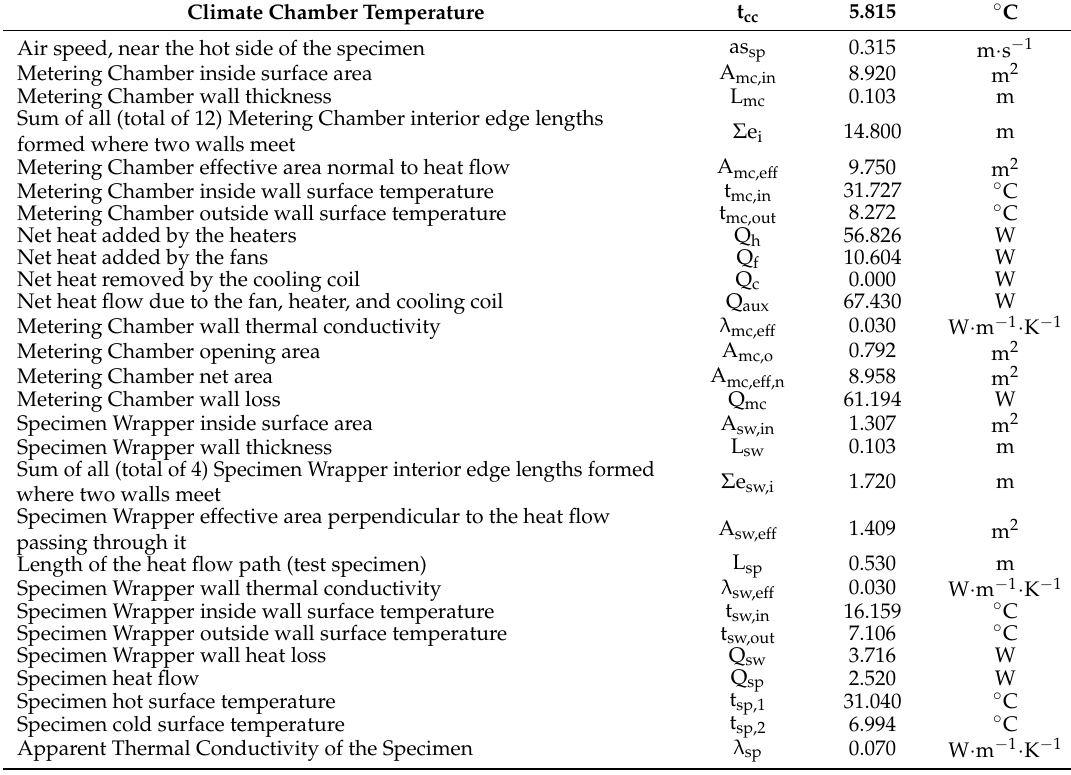
Table 10. Calculation of the thermal conductivity of the specimen